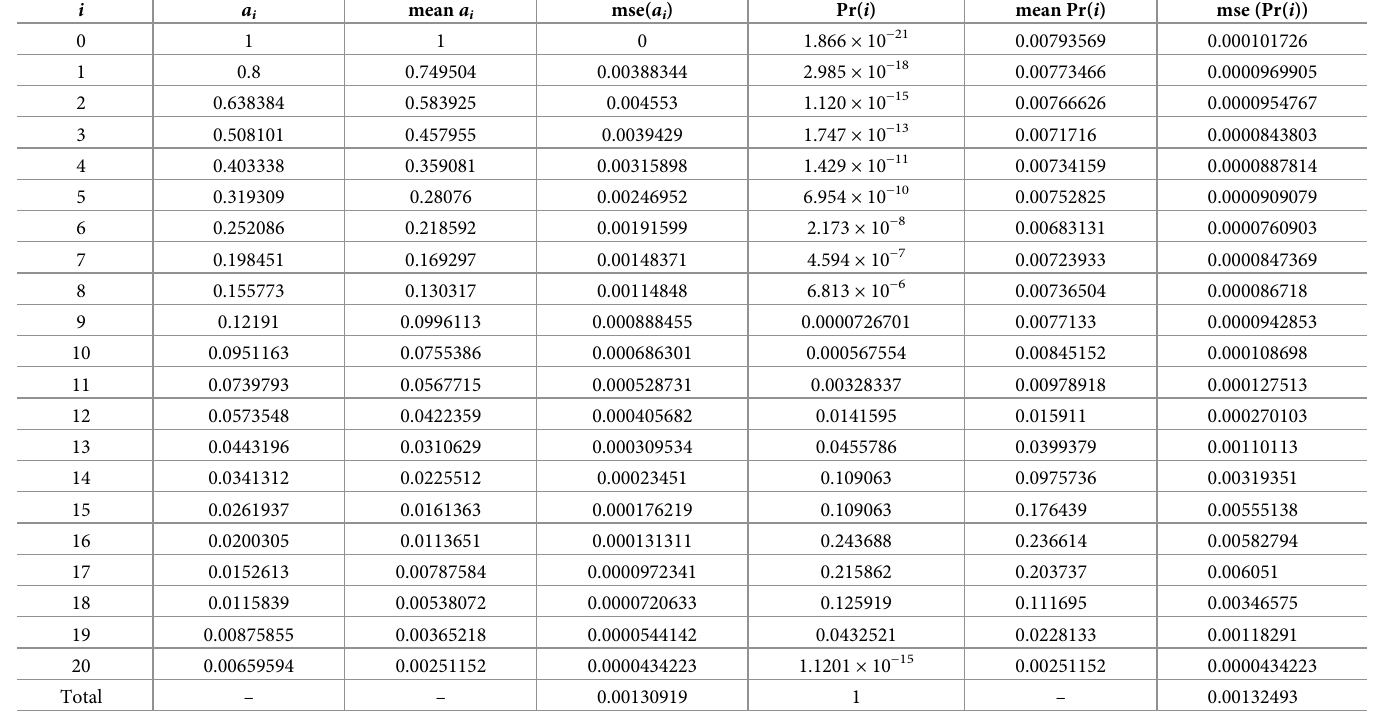
Table 7. Scenario 1. H (100, 80, n ) where n = 5, 10,